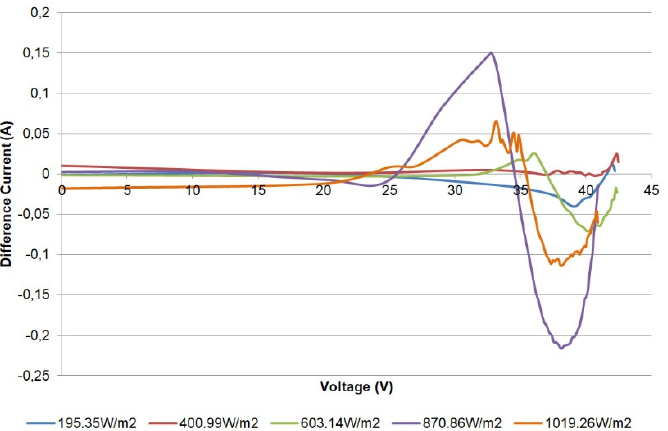
Figure 17. Difference of measured and simulated currents for the single PV module.